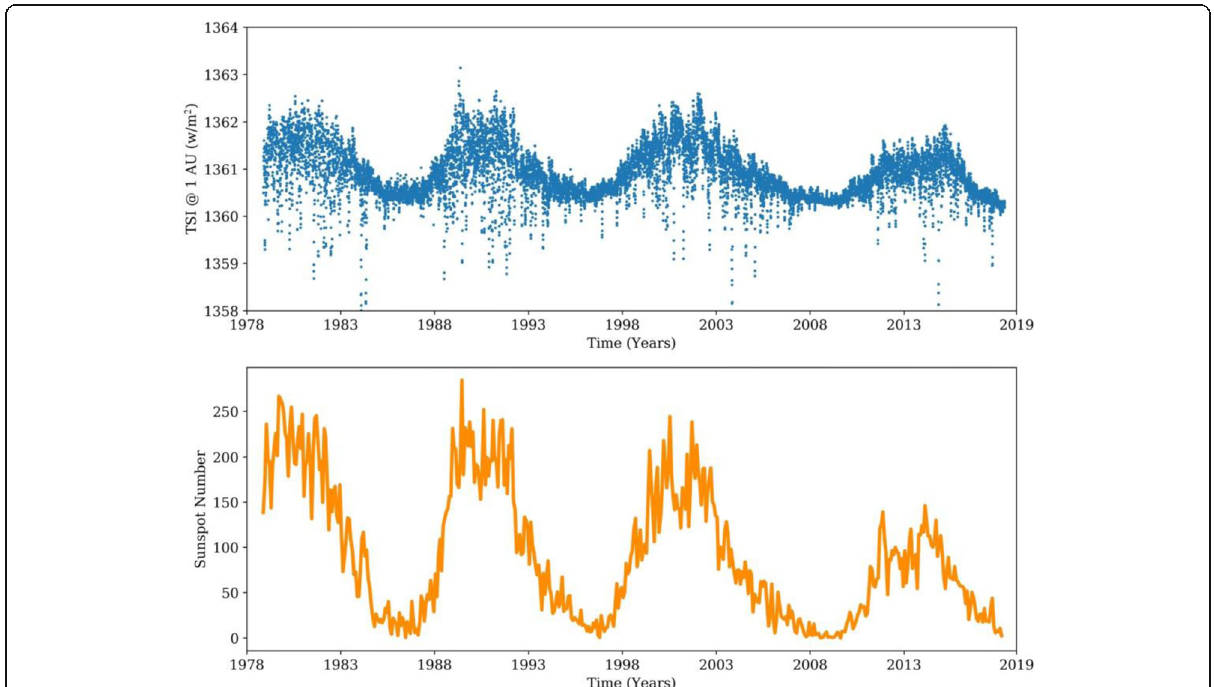
Fig. 9 Comparison of total solar irradiance (TSI) variations (top panel) with the sunspot time series (bottom panel). The TSI varies in phase with the solar cycle indicating that during phases of very strong activity, the total radiation output — and hence radiative forcing of the heliosphere — is enhanced. The composite TSI time series data is acquired from PMOD/WRC (Fröhlich